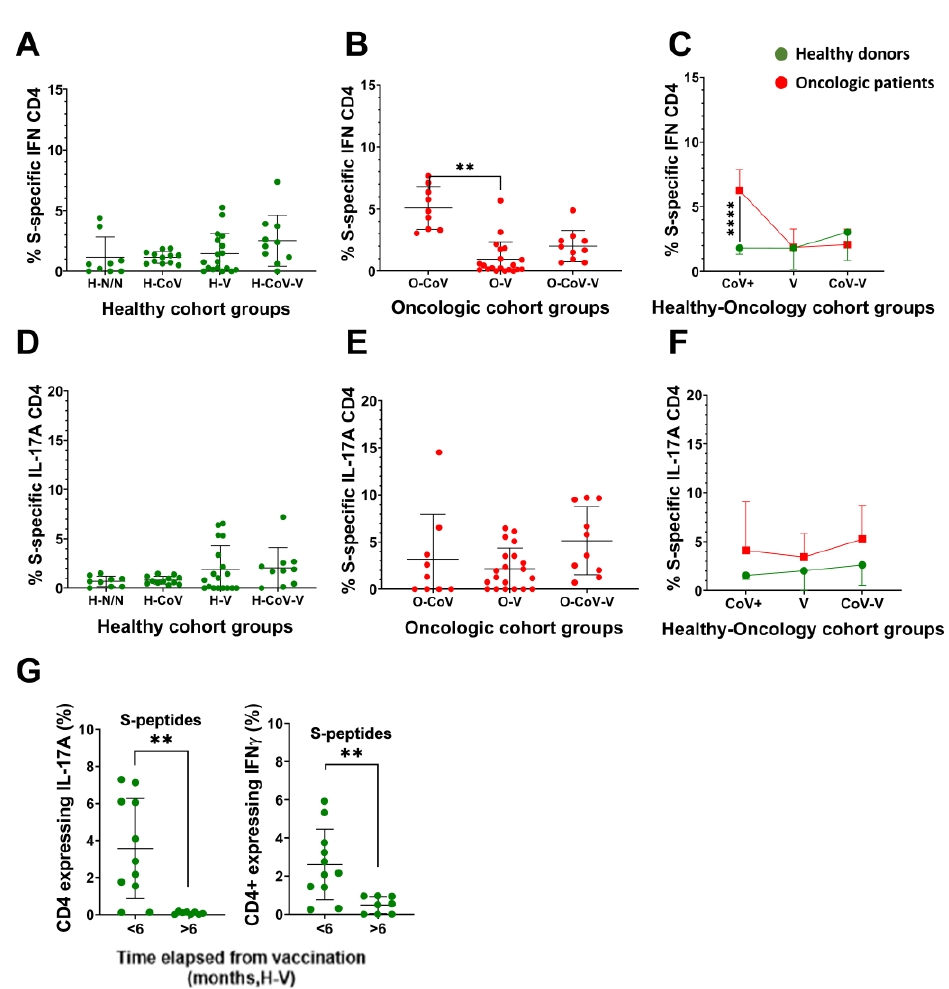
Figure 4. IFN γ and IL-17 expression in S-specific CD4 T-cells. Paired backgrounds from technical controls were removed from the data. ( A – C ) Percentage of IFN γ -CD4 T-cells specific for the S protein in healthy donors and oncologic patients. ( D – F ) Percentage of IL-17-CD4 T-cells specific for the S protein in healthy donors and oncologic patients. ( A , B , D , E ) Statistical significance was evaluated with the Kruskal–Wallis test, followed by Dunn ´ s pair-wise comparisons. ( G ) Percentage of CD4 T-cells expressing IL-17 and IFN γ in H-V donors that completed the vaccine regime before sample collection in the indicated timelines. ( C , F , G ) Significance was tested with the